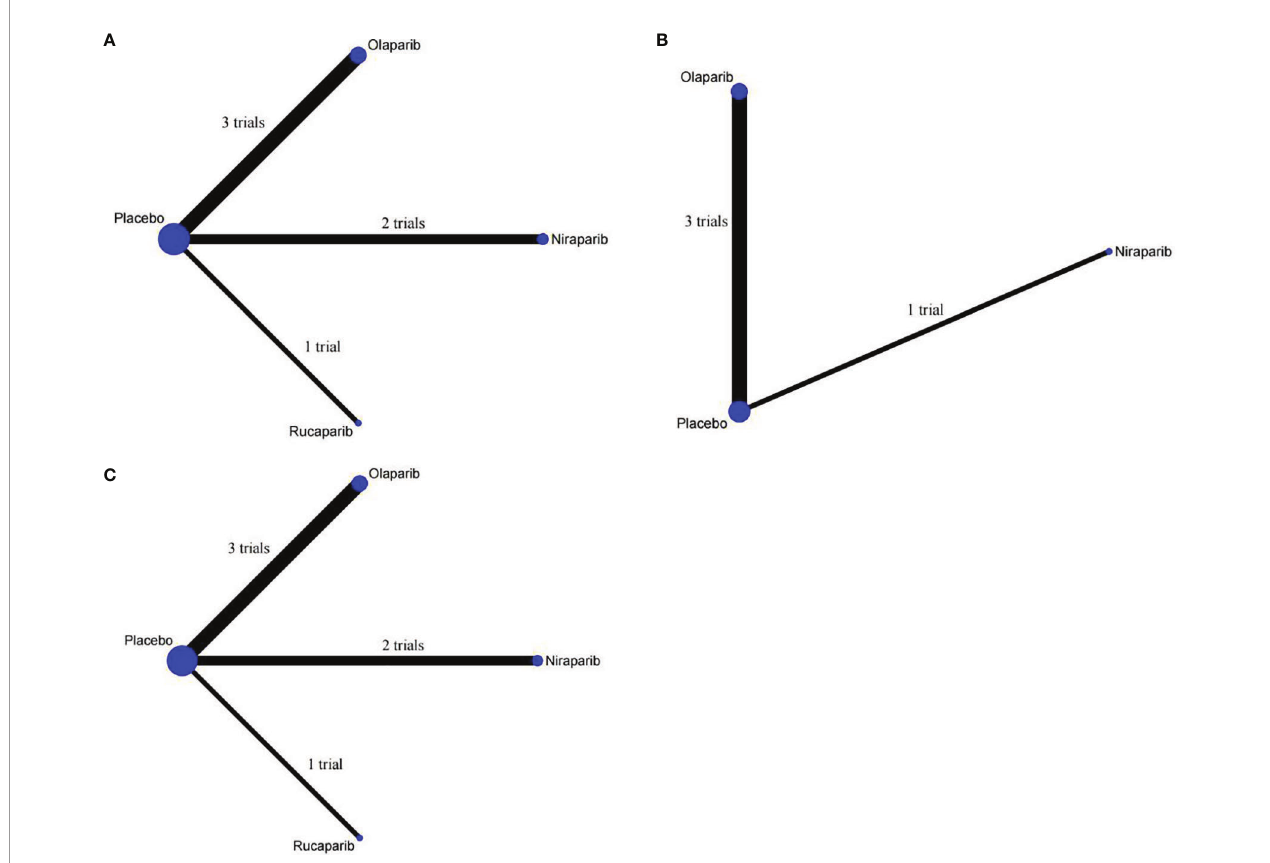
FIGURE 3 | Network plot of different outcomes in patients with ovarian cancer. (A) Comparisons on progression-free survival in patients with ovarian cancer. (B) Comparisons on overall survival in patients with ovarian cancer. (C) Comparisons on grade ≥ 3 adverse events in patients with ovarian